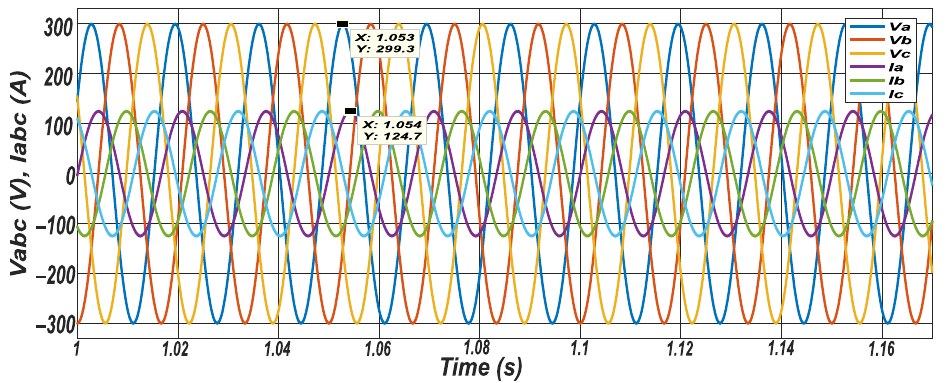
Figure 7. Peak voltages and currents measured at PCC or B_12.